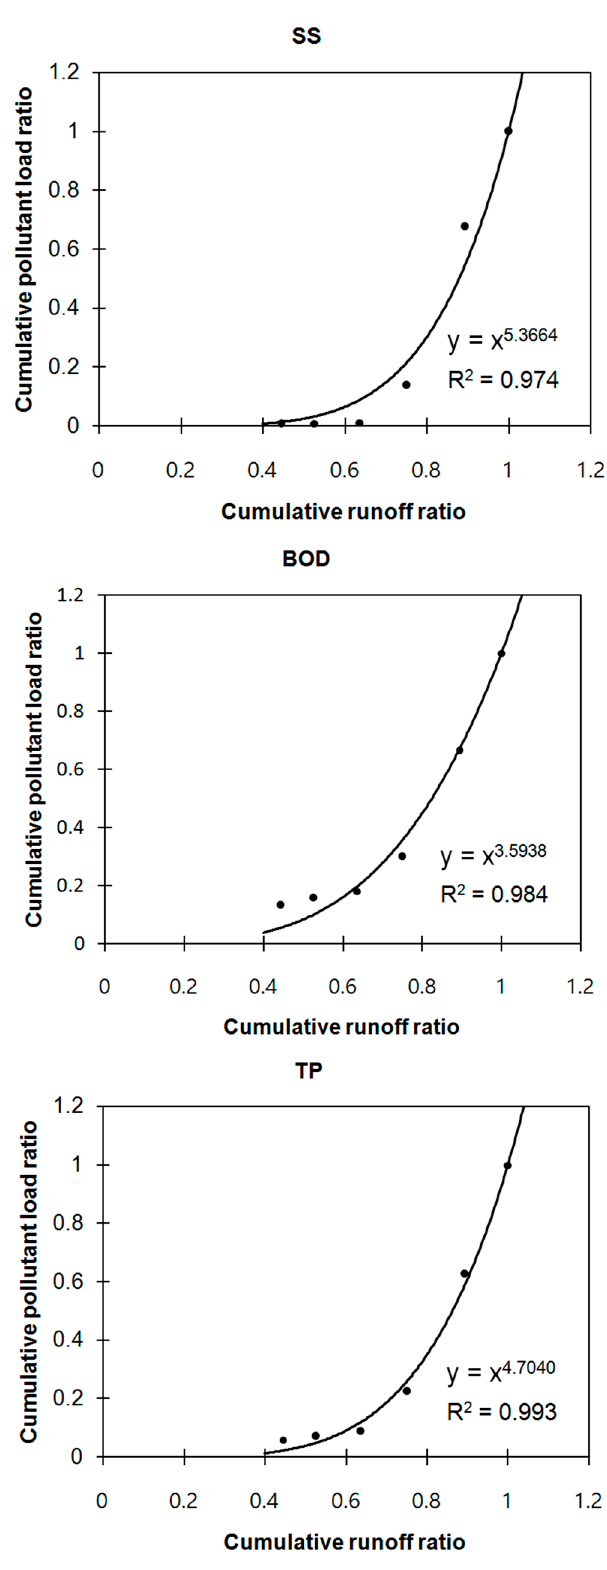
Figure 11. M(V) curve fitting using the power function for Jungjohangcheon (1–3 October 2016). Figure 11. M ( V ) curve fitting using the power function for Jungjohangcheon (1–3 October